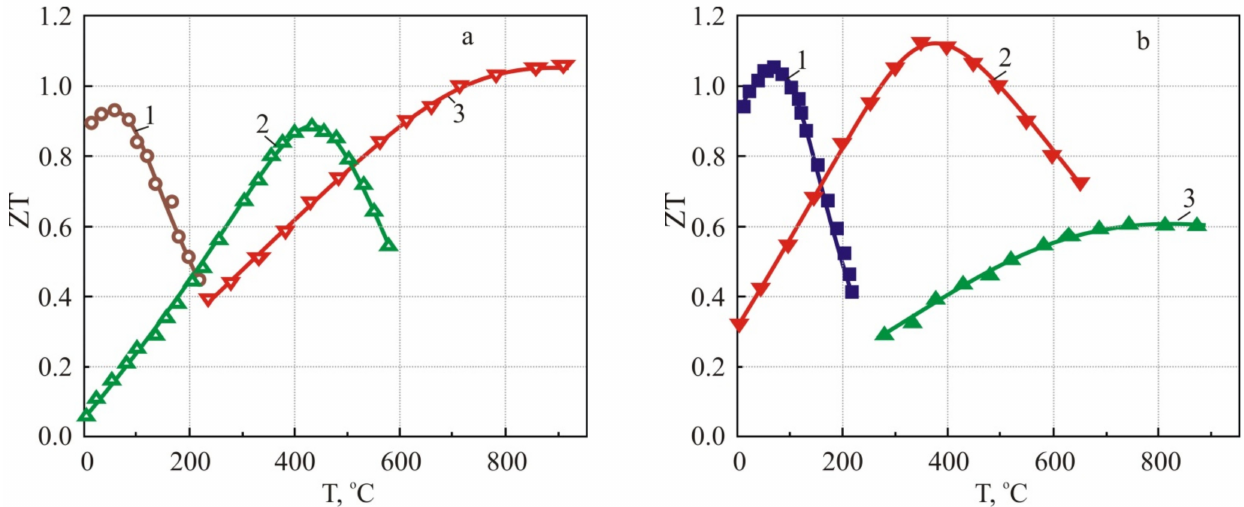
Figure 1. Temperature dependence of dimensionless figure of merit zt for various thermo- electric materials over 30–900 ◦ C [15–26]. ( a ) n -type: 1—Bi 2 Te 3 − x Se x . 2—PbTe. 3—Si 1 − x Ge x . ( b ) p -type: 1—Bi 2 − x Sb x Te 3 . 2—GeTe. 3—Si 1 − x Ge x